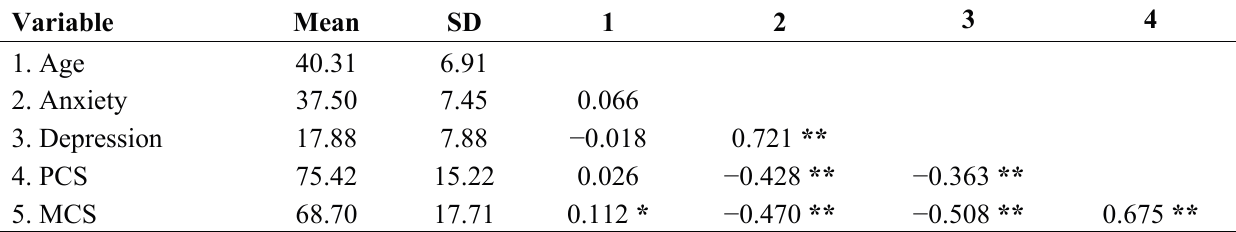
Table 2. Means, standard deviations (SDs) and correlations of continuous